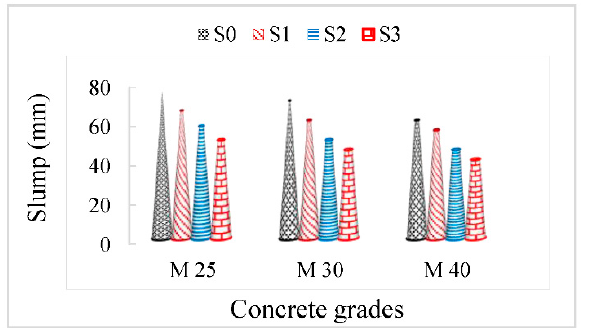
Figure 3. The slump results. S0 (100% PLC), S1 (95% PLC + 5% CNA), S2 (90% PLC + 10% CNA), S3 (85% PLC + 15%